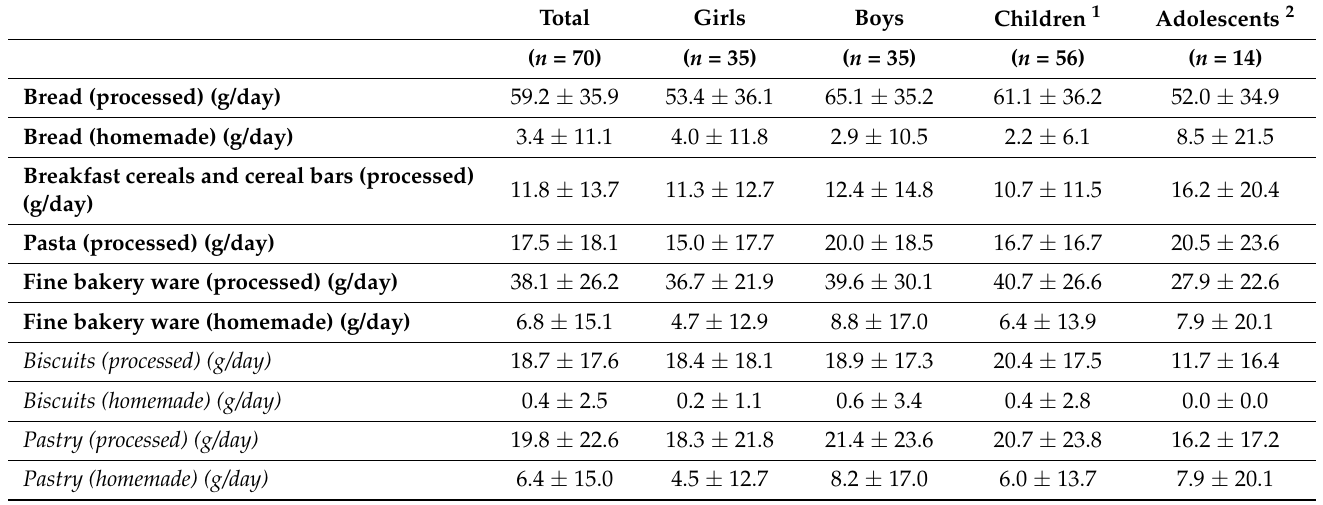
Table 1. Daily intake of processed and homemade cereal-based gluten-free products in Spanish children and adolescents with celiac